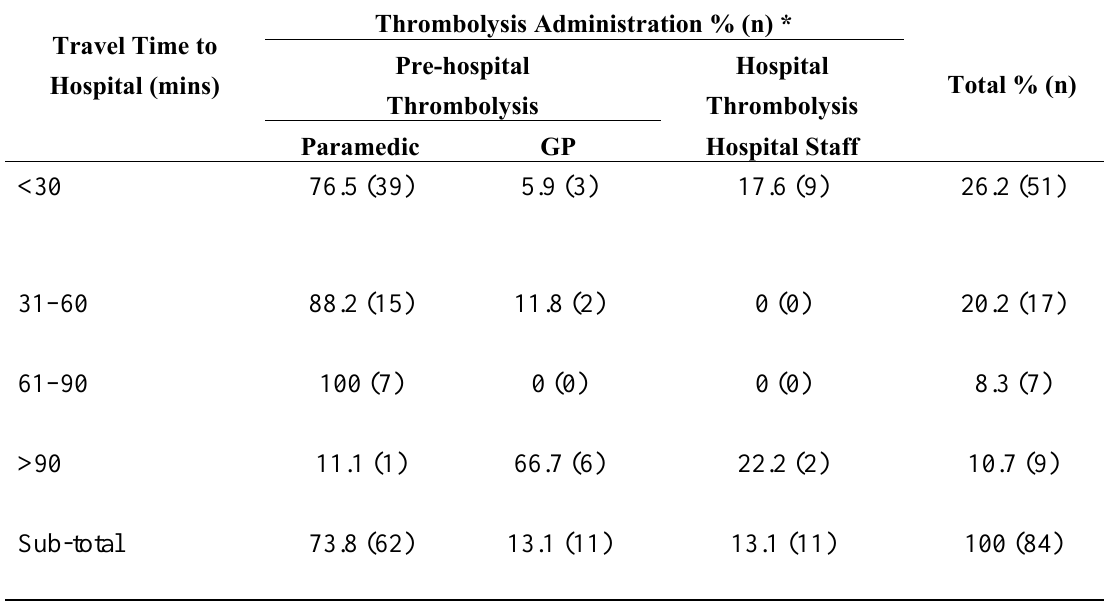
Table 3. Proximity to hospital at time of event vs. location and administrator of thrombolysis (n =